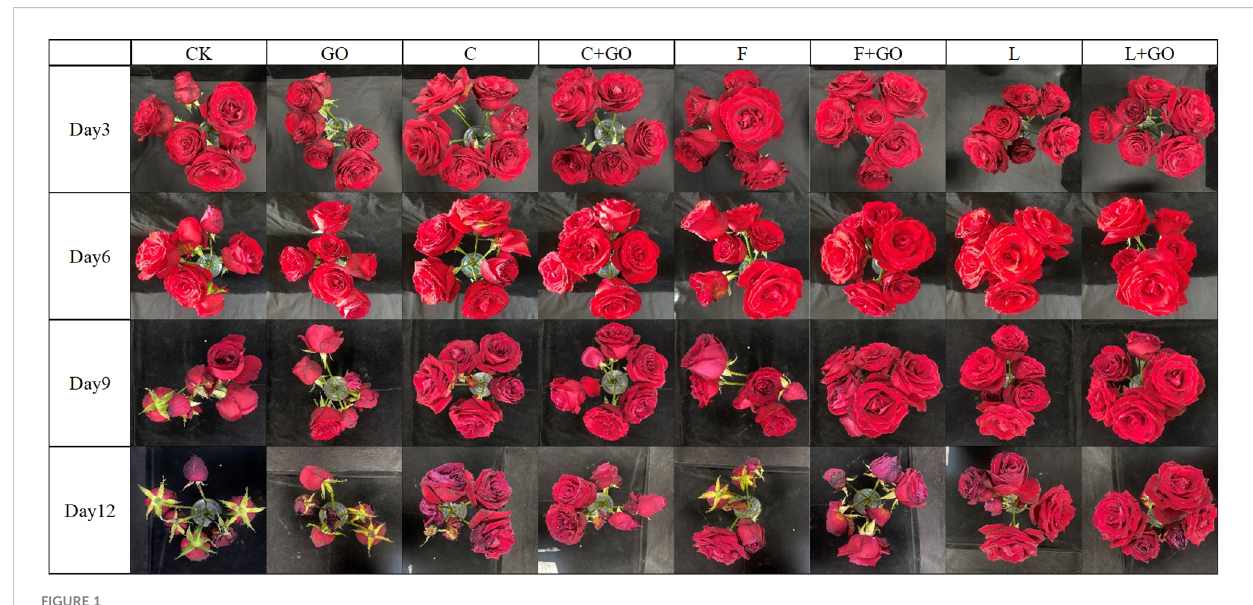
FIGURE 1 Top view of the cut rose fl owers in different